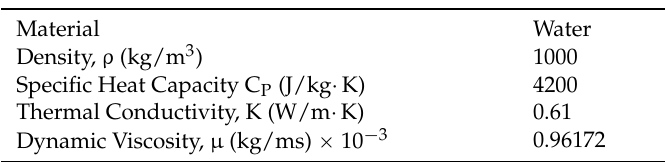
Table 7. Thermophysical properties of copper